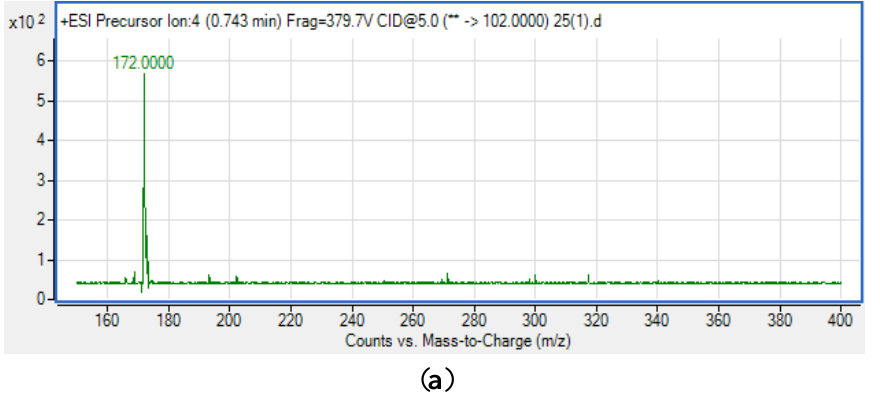
Figure 5. Mass spectrometry analysis of AHLs produced by Serratia fonticola RB-25. Mass spectra show that S . fonticola produces C4-HSL ( a ) (retention time: 0.743